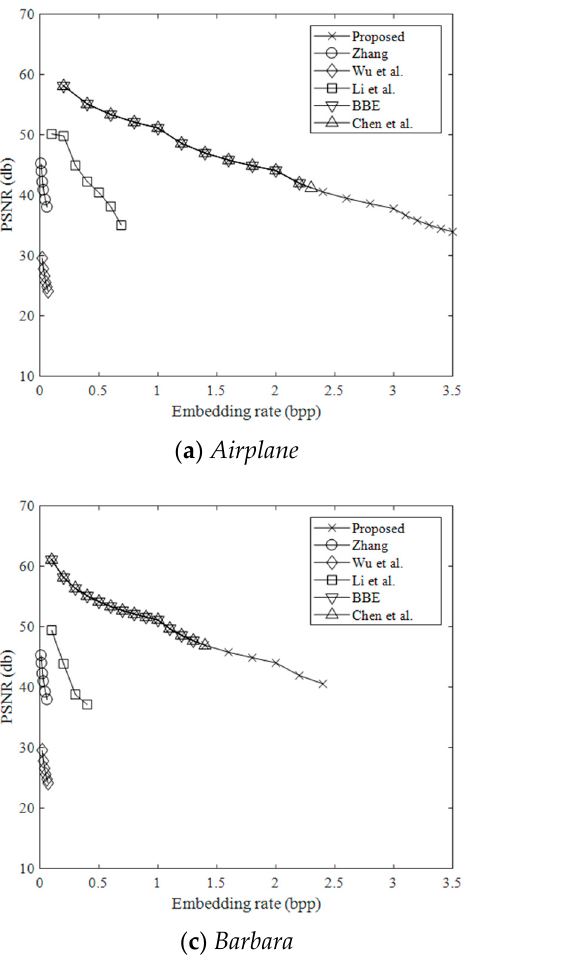
Figure 8. Comparison of the marked decrypted image quality ( Airplane , Baboon , Barbara , Couple ).